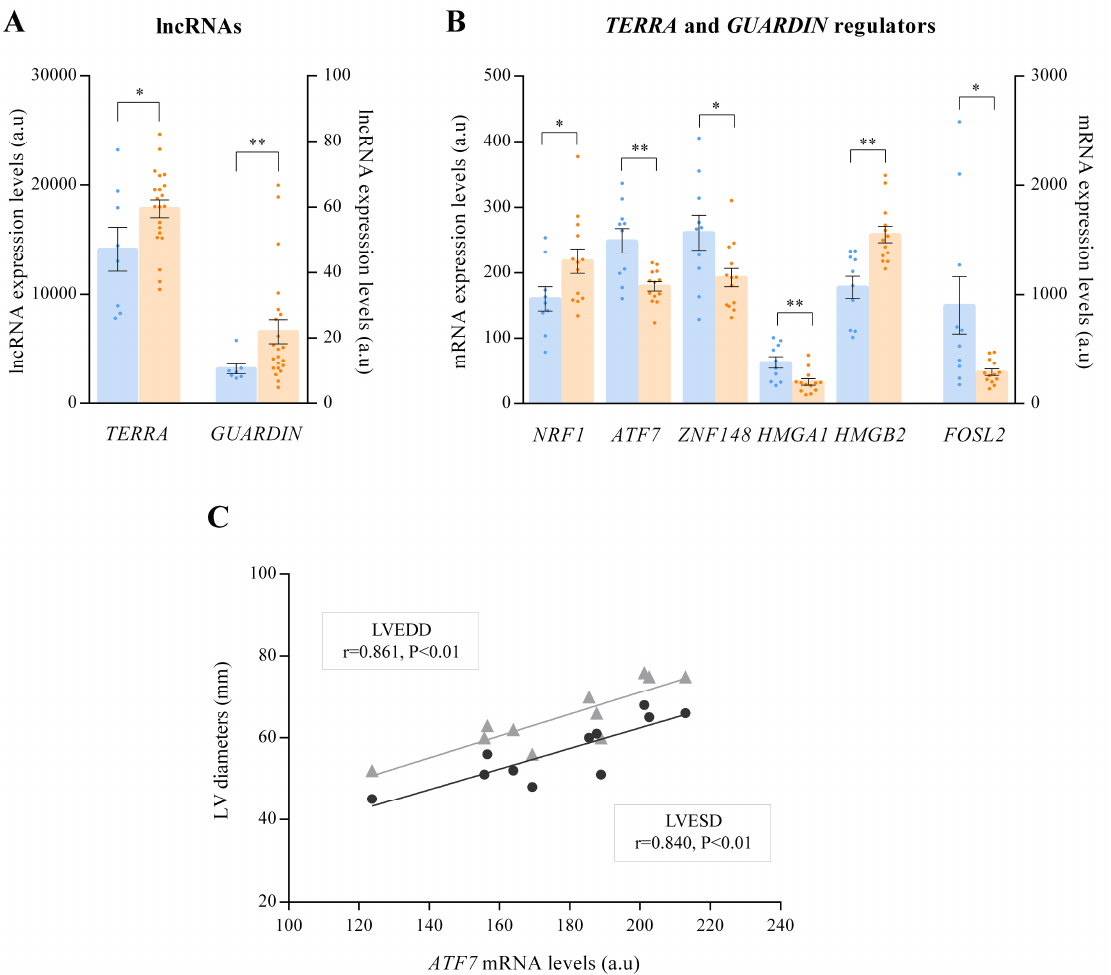
Figure 2. Dot plot graph of lncRNAs expression and mRNA expression levels of altered genes associated with TERRA and GUARDIN regulation. ( A ) TERRA and GUARDIN expression. ( B ) Genes involved in TERRA and GUARDIN regulation. ( C ) Correlation of ATF7 mRNA levels with left ventricular end-systolic (LVESD) and left ventricular end-diastolic (LVEDD) diameters. The results were obtained by mRNA-sequencing SOLiD 5500XL platform and ncRNA-sequencing Illumina HiSeq 2500 platform. Data are presented as the mean ± SEM. au, arbitrary units. Ischemic cardiomyopathy patients (orange), controls subjects (blue). Left ventricular end-systolic diameter (black), left ventricular end-systolic diameter (grey). * p < 0.05, ** p <